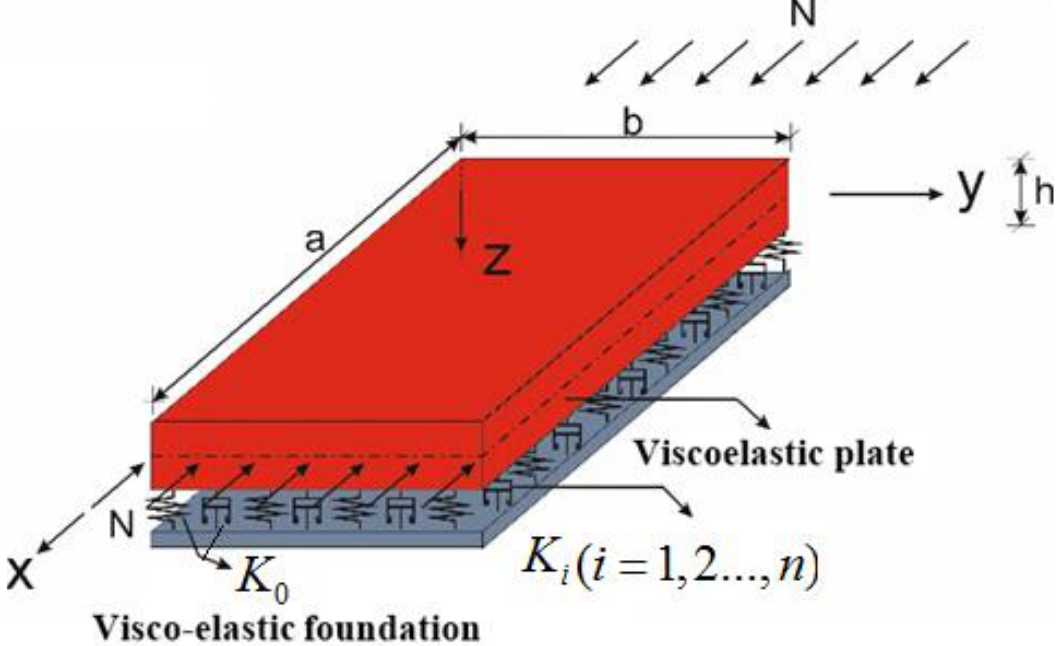
direction, and resting on a